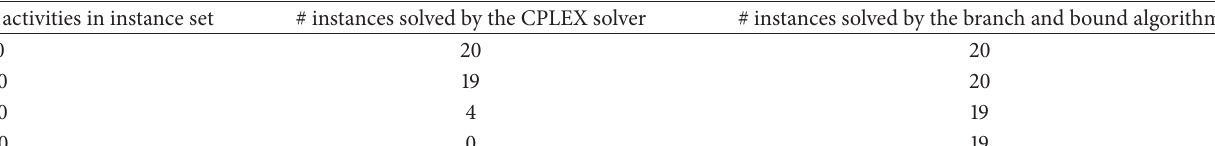
Table 1: Number of instances of each set of group I out of 20 solved to optimality in 10 seconds by the branch and bound algorithm and the CPLEX solver.